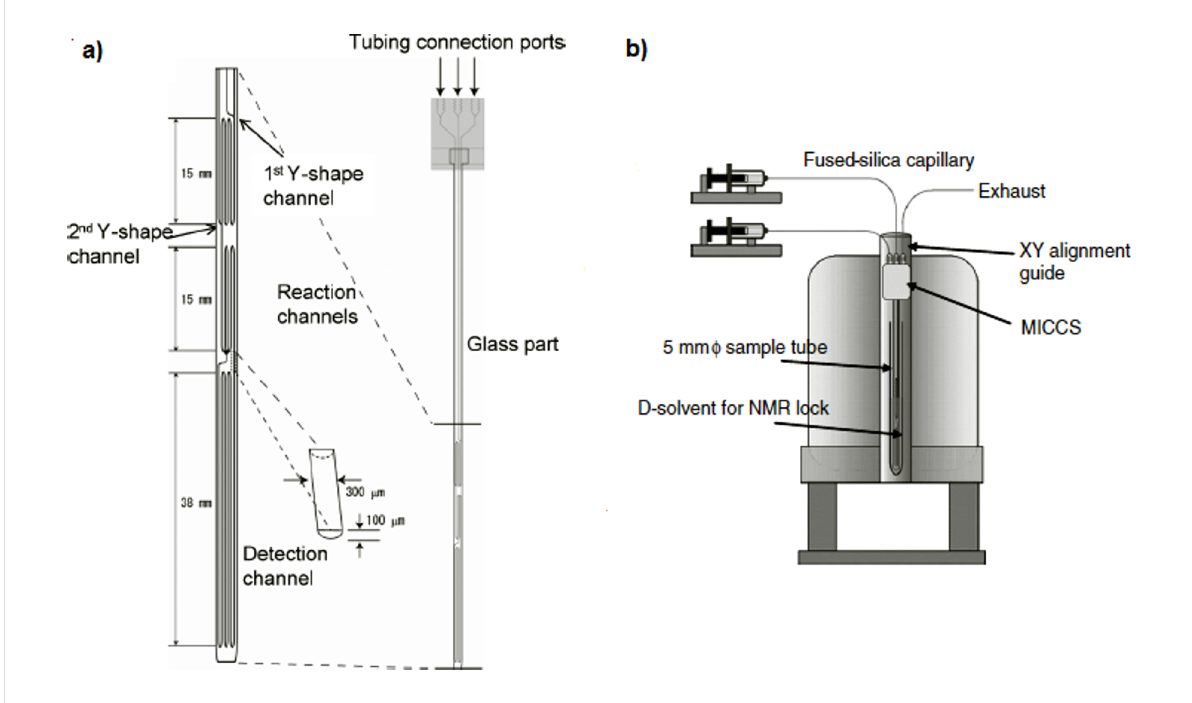
Figure 8: a) Design of MICCS and b) schematic diagram of MICCS–NMR [45]. CH 2 Cl 2 solutions of oxime ether and triethylborane were introduced into MICCS by two inlet ports and mixed at the first Y-shape channel (Flow rate 5 μ L min − 1 ). A CH 2 Cl 2 solution of methanol was introduced and mixed with reaction mixture at the second Y-shape channel to quench the reaction. Reproduced with permission from reference [45]. Copyright 2007 John Wiley and Sons.